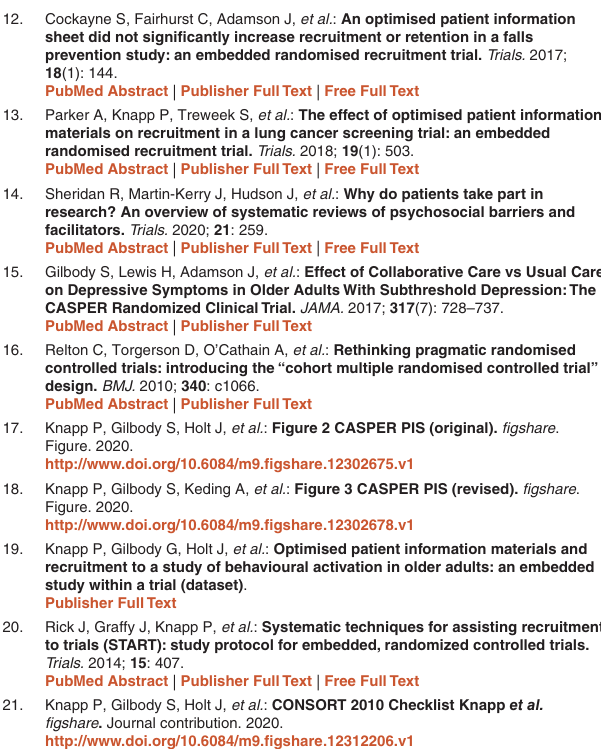
Figshare: Figure 3 CASPER PIS (revised). https://doi.org/10.6084/